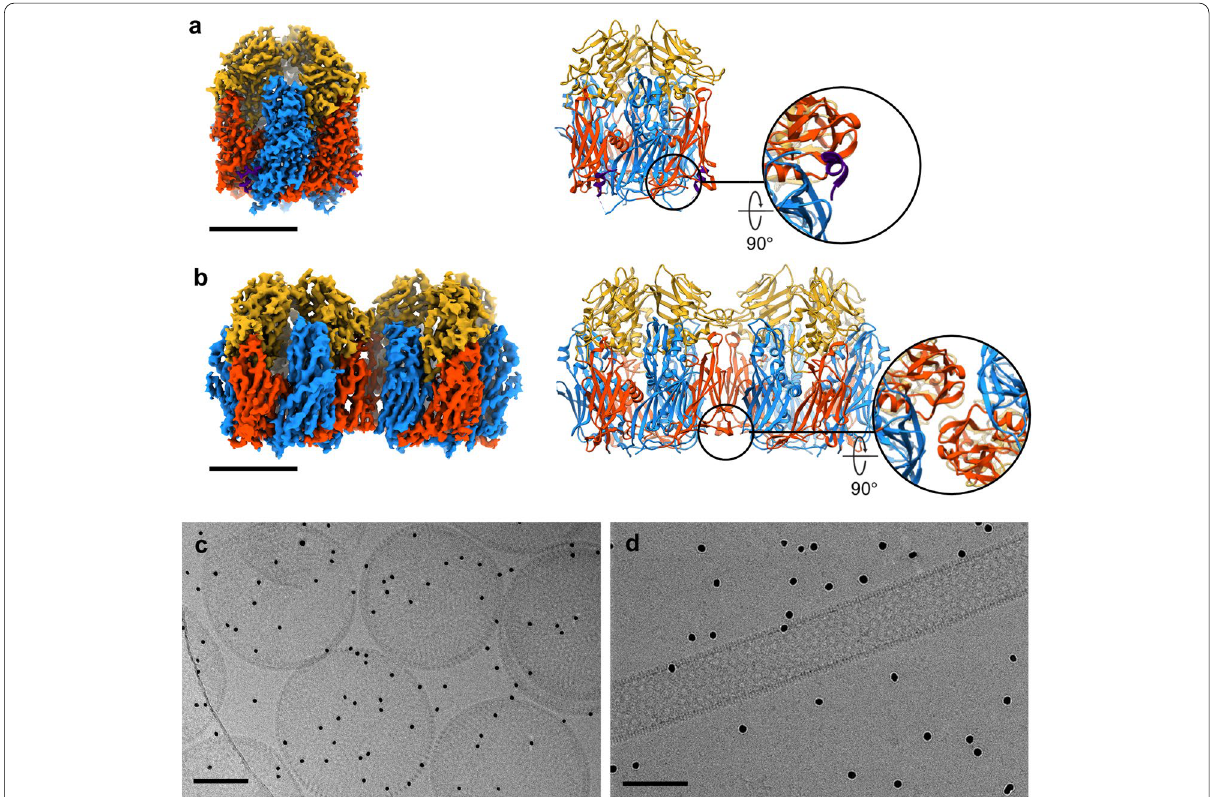
Fig. 4 Cryo-EM structure of VACV D13 and its assembly. a Single particle cryo-EM 3D reconstruction of VACV scaffolding protein D13 in its native trimeric form (left) and the ribbon representation of its atomic model with a close-up view of N-terminal tail α-helix (right). b Single particle cryo-EM 3D reconstruction of D13 trimer doublet (left) and the ribbon representation of its atomic model with a close-up view of the inert-trimer interface where N-terminal tail α-helix is missing (right). The reconstructions and the models are colored according to domains in D13 monomer (blue: N-terminal jellyroll domain, red: C-terminal jellyroll domain, yellow: head domain, purple: N-terminal tail α-helix helix). c Spherical and d tubular assemblies produced in vitro under low salt condition when the N-terminal tail α-helix is dislocated or truncated, suggesting that the disposition of the helix triggers D13 self-assembly into IV scaffold. Scale bars are 5 nm in ( a ) and ( b ), and 100 nm in ( c ) and ( d